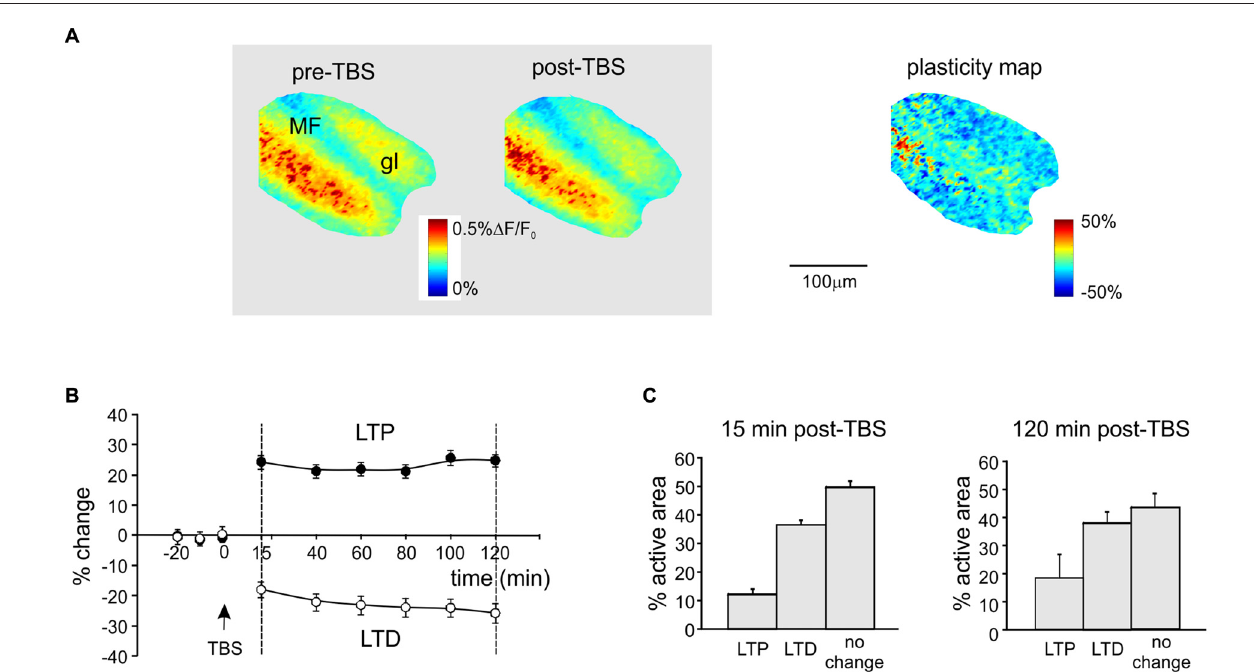
FIGURE 1 | Spatial distribution of long-term potentiation and depression (LTP and LTD) in the granular layer after theta-burst stimulation (TBS). (A) Activation maps of the granular layer (elaborated from Voltage-sensitive dye imaging (VSDi) signals) in response to a single pulse delivered to the mossy fibers (MFs) before and 120 min after TBS ( left ). The plasticity map ( right ) reveals the distribution of changes induced by TBS. MFs, mossy fibers; gl, granular layer. (B) Average time course of LTP and LTD in eight different slices (mean and SEM, n = 8; see “Materials and Methods” Section for pixels acceptance criteria). The TBS is delivered at time 0. (C) Histograms showing the percentage of active pixels displaying LTP or LTD in the early phase (15 min, left ) and in the late phase (120 min, right ) of expression after TBS (mean and SEM, n = 8).